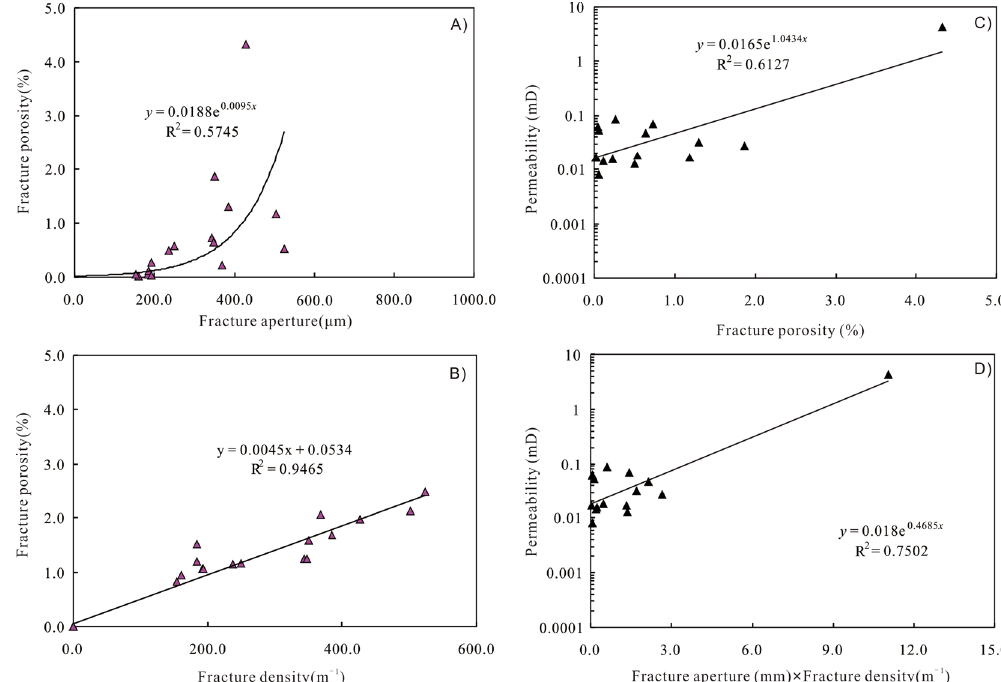
Figure 8. ( A ) Plot of fracture porosity versus facture aperture; ( B ) Plot of fracture porosity fracture density; ( C ) Plot of horizontal permeability versus facture porosity; ( D ) Plot of horizontal permeability versus fracture aperture (mm) multiplied by fracture density (m − 1